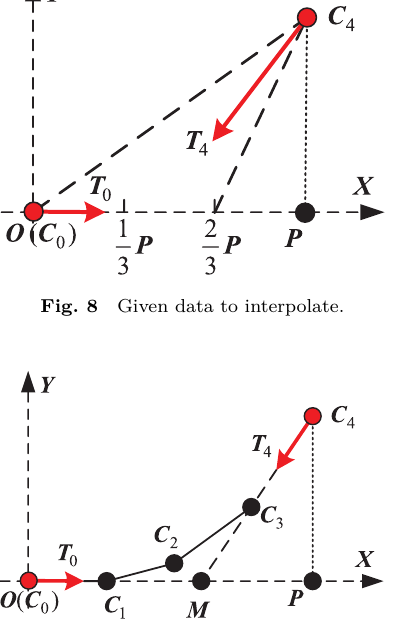
Fig. 9 Generating the middle control